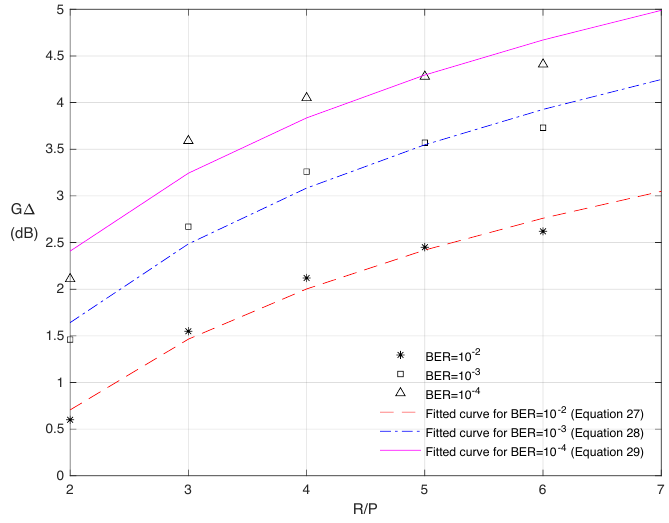
Figure 5. Difference between theoretical BER performance for SISO and MIMO systems for the first iteration when using